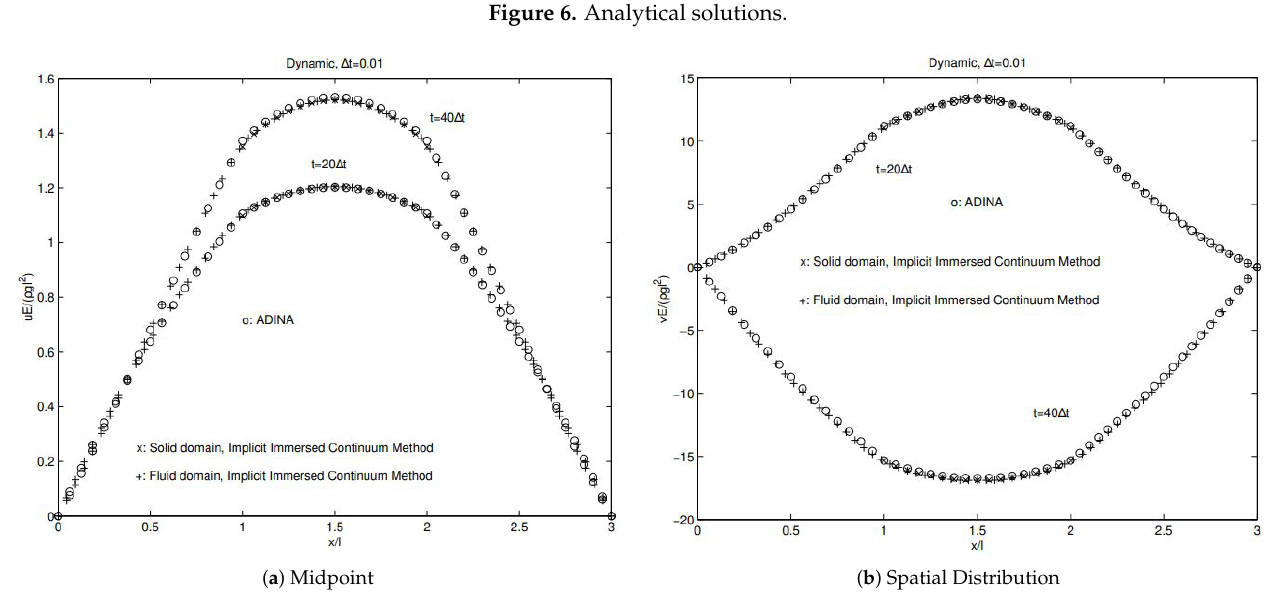
Figure 7. Comparisons with the monolithic implicit immersed method with matrix-free Newton–Krylov iterations and